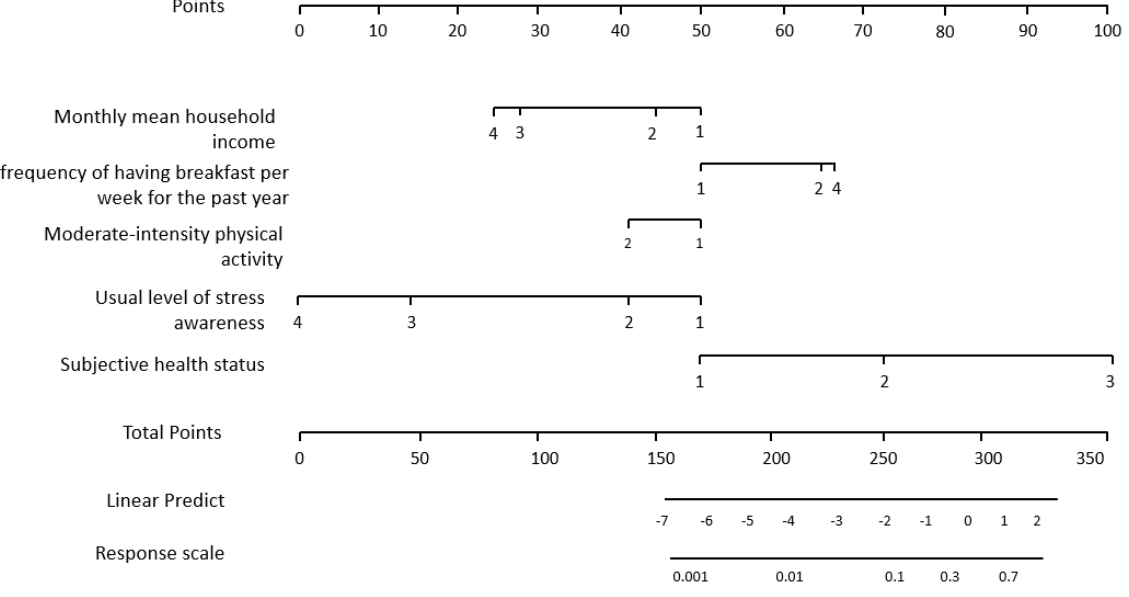
Figure 1. The nomogram for predicting depression in older adults in the community based on multiple risk factors. Second, a risk factor line was presented. This line indicates the range of a risk factor that affects the occurrence of an event. The number of risk factor lines is equal to the number of risk factors. Third, this study presents a probability line. The probability line is the sum of finally calculated nomogram scores, and it is placed at the bottom of the nomo- gram to derive the occurrence probability of a major depressive disorder. The fourth is the total point line, calculated and constructed based on a statistical model. Monthly mean household income: 1 ≤ KRW 1.5 million, 2 ≥ KRW 1.5 million and <